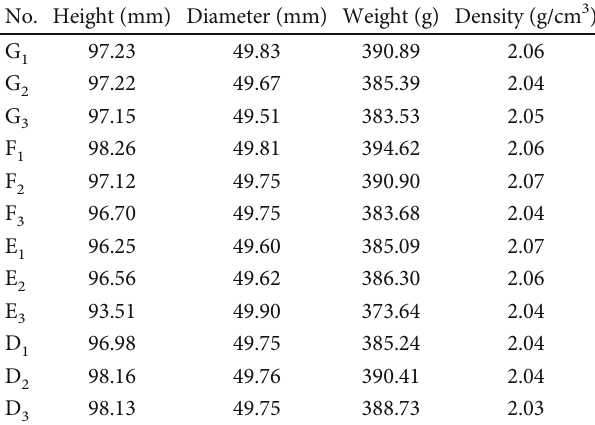
Figure 3: Cyclic con fi ning pressure loading and unloading paths. Table 1: Selected sample parameters.